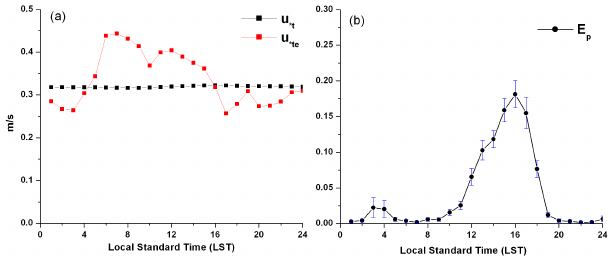
Fig. 6. Average diurnal profile of (a) threshold friction velocity and (b) average normalized hourly emission flux with standard deviation (shown as error bars) for oak pollen emission during flowering season at Pasadena, California.